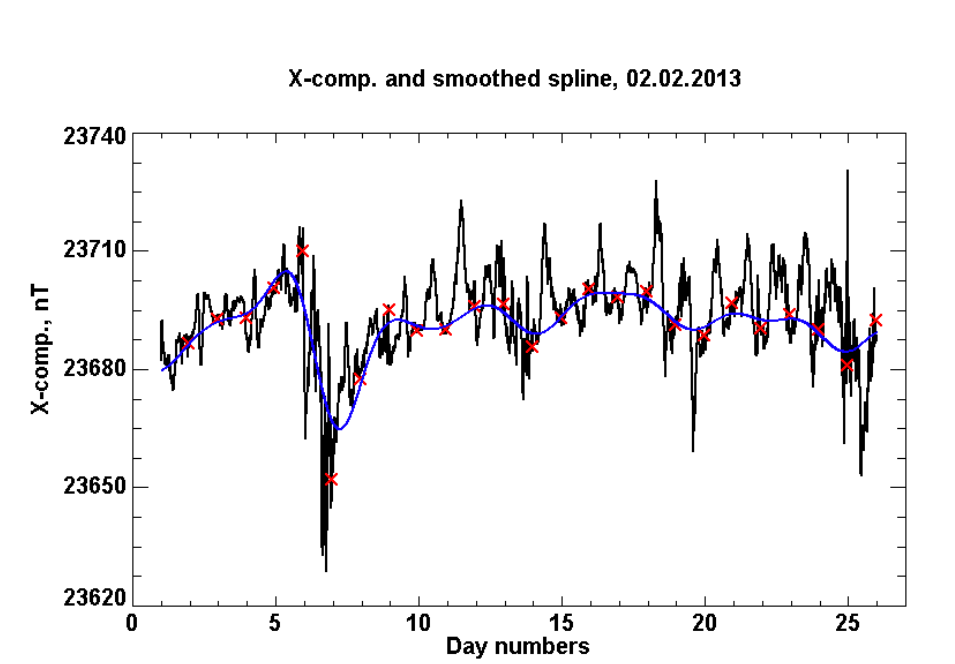
Fig.4 . X-component series for 25 days, centered on 02 February 2013. The midnight points (24 LT) are marked by ”x” sign. The computed smoothed spline through the midnight points is drawn by a continuous line.